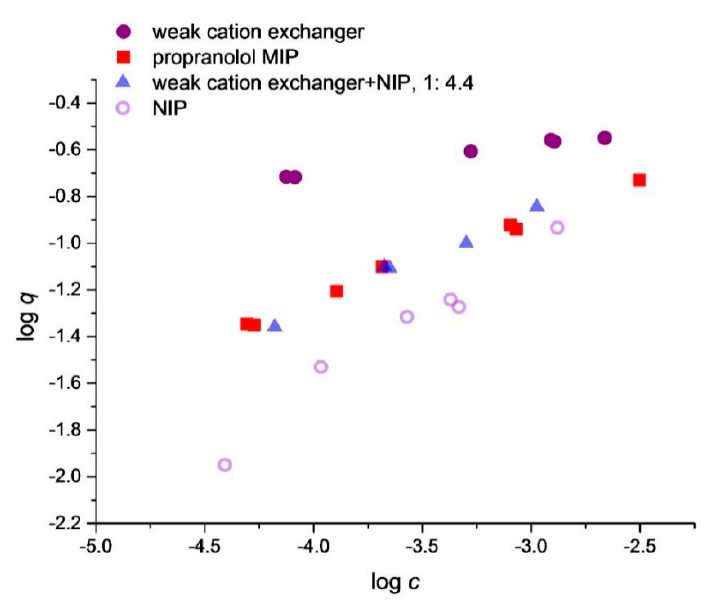
Figure 2. Adsorption isotherm of propranolol on different polymers and on a polymer mixture, measured in acetonitrile.